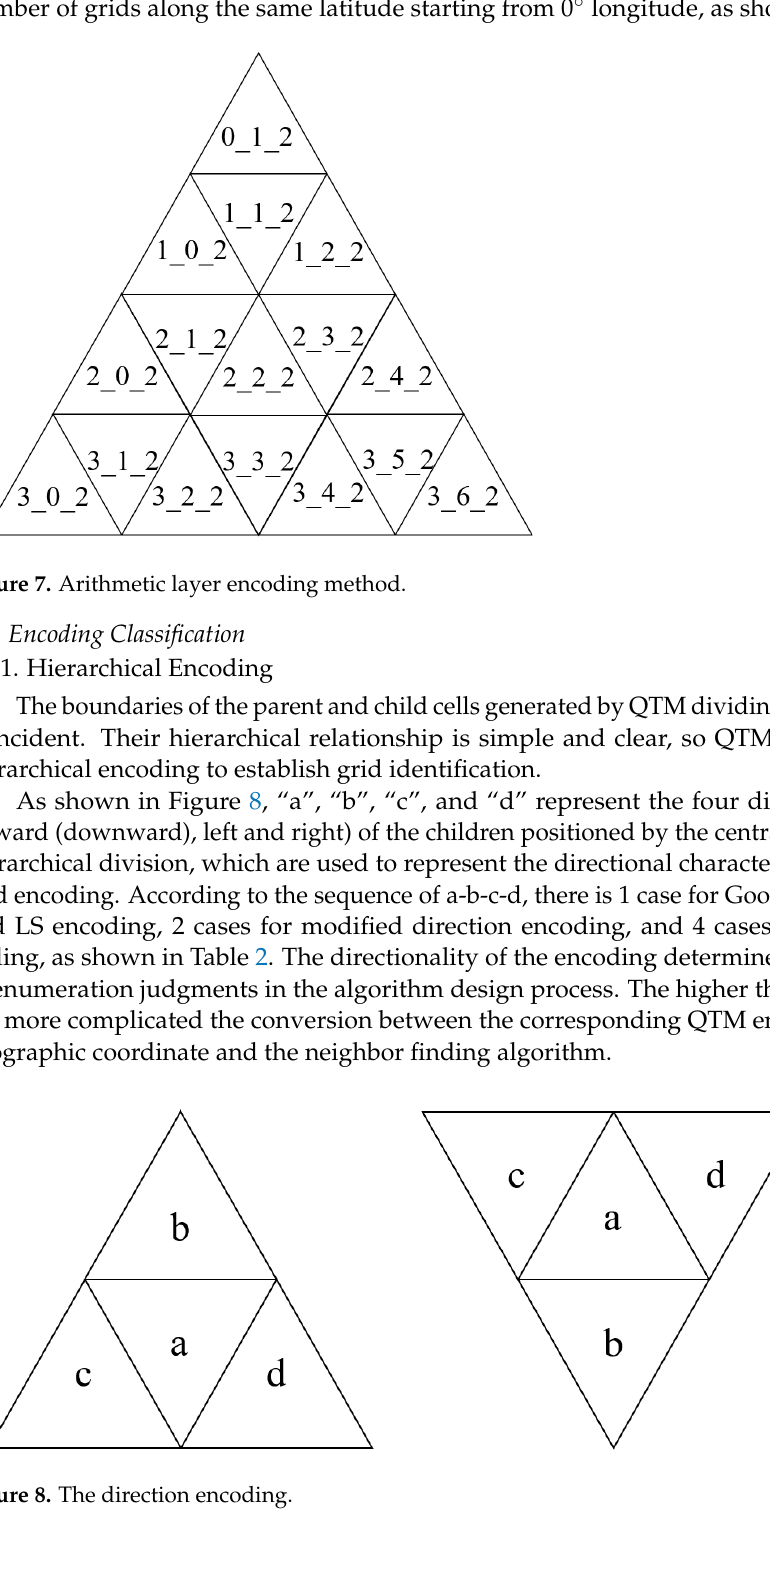
Figure 6. TRQ encoding method.